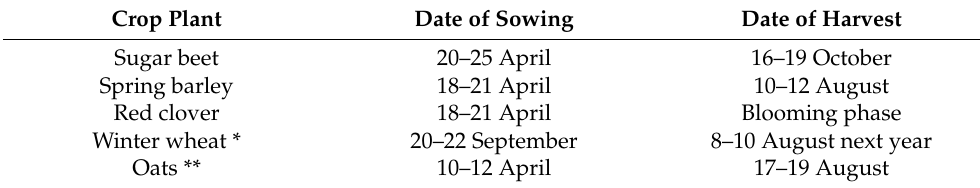
Table 3. Dates for sowing and harvesting crops in the crop rotation.